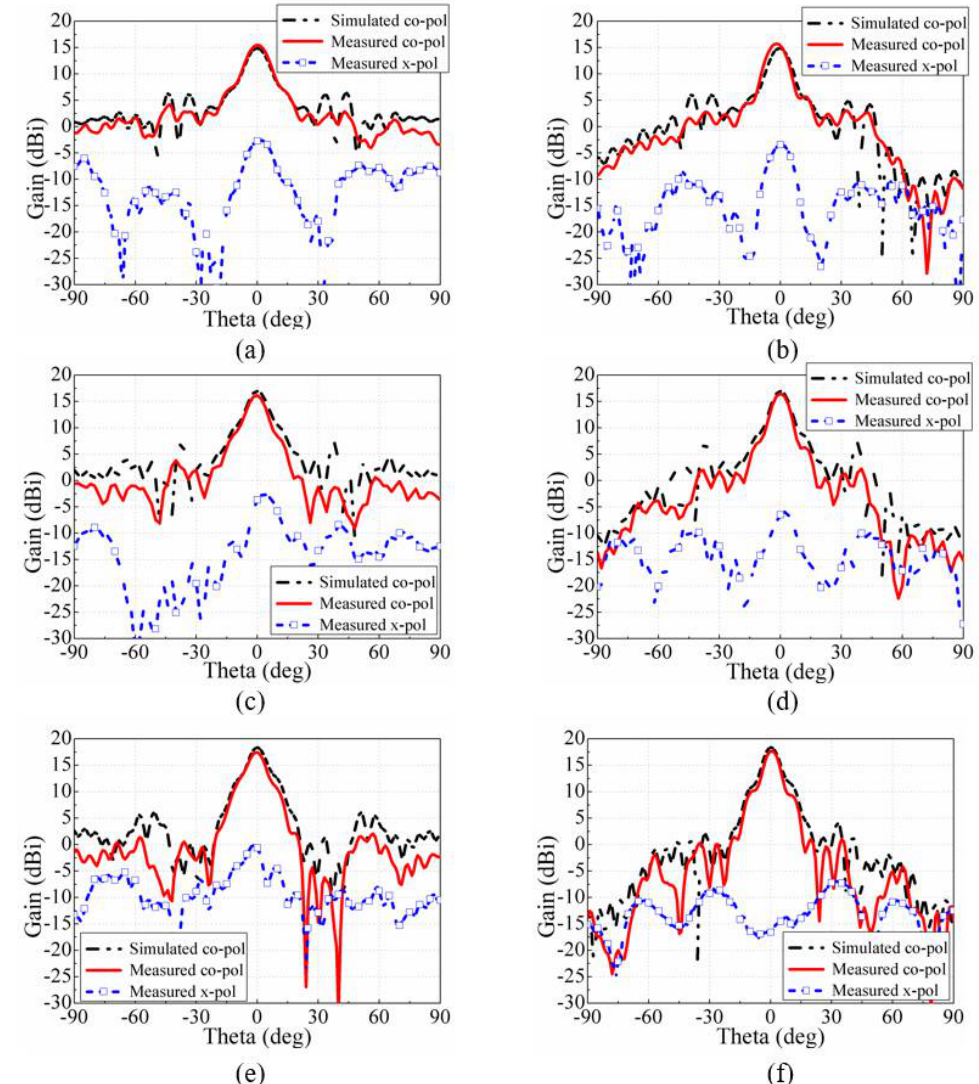
Figure 9. Simulated and measured radiation pattern for Yagi antenna with the proposed fractal GRIN lens in ( a ) E-plane and ( b ) H-plane at 24 GHz; ( c ) E-plane and ( d ) H-plane at 28 GHz; and ( e ) E-plane, and ( f ) H- plane at 32 GHz.